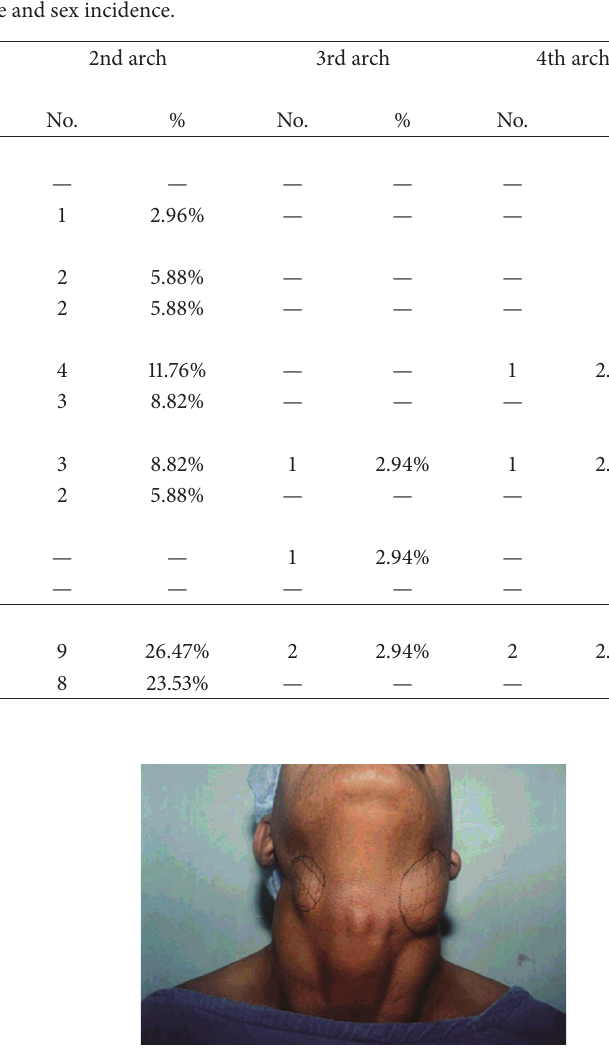
Figure 5: Fourth branchial anomaly.